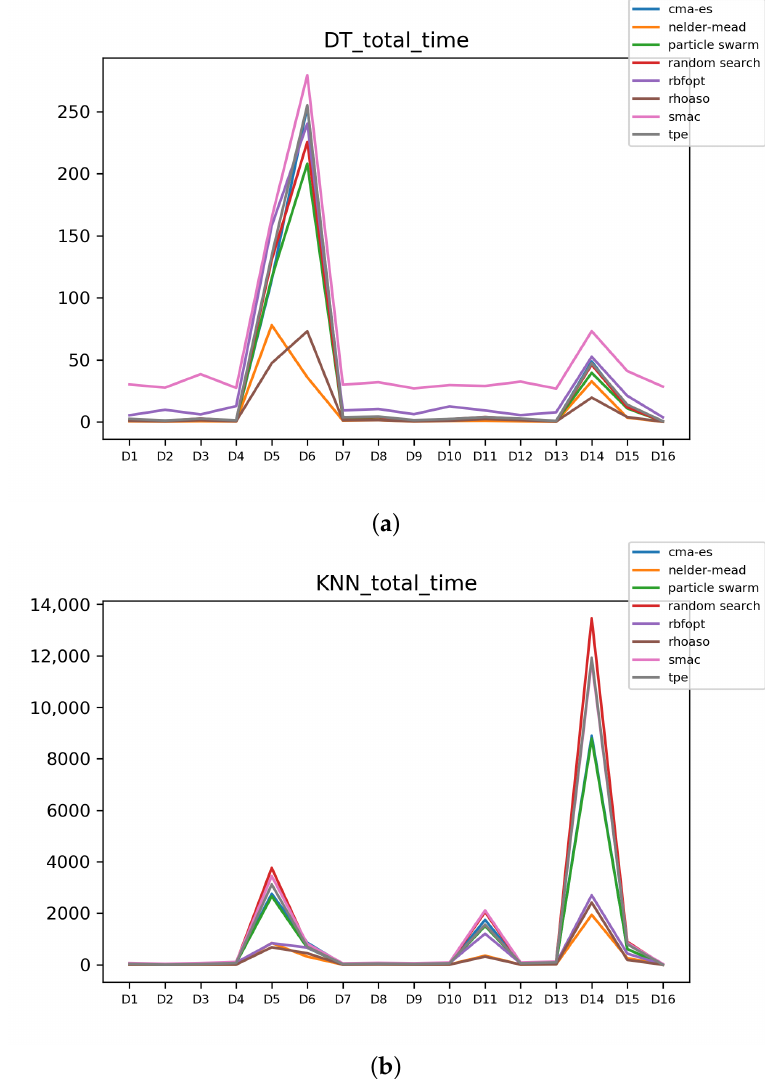
Figure A8. Time complexity. ( a ) Time complexity in DT. ( b ) Time complexity in KNN.